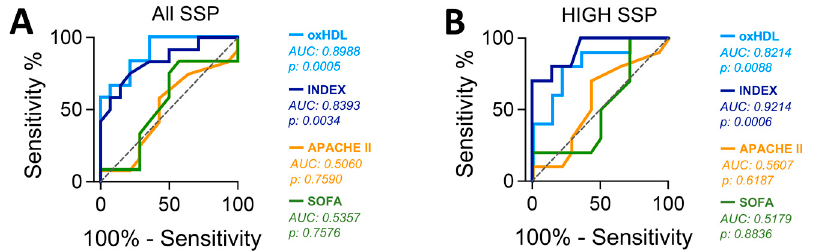
Figure 4. Plasma level of oxHDL and INDEX in SSP. AUROC curve analysis in all SSP ( A ) and non-surviving SSP ( B ) were performed for the plasma level of high-oxHDL (( A ), AUC = 0.8988, p = 0.0005 (95% CI: 0.7835–1.001); ( B ), AUC = 0.8214, p = 0.0885 (95% CI: 0.6480–0.9948)), high-INDEX (( A ), AUC = 0.8393, p = 0.0034 (95% CI: 0.6838–0.9948); ( B ), AUC = 0.9214, p = 0.0006 (95% CI: 0.8155–0.9998)), APACHE II (( A ), AUC = 0.5060, p = 0.7590 (95% CI: 0.2753–0.7366); ( B ), AUC = 0.5607, ( B ), AUC = 0.5179, p = 0.8836 (95% CI: 0.2738–0.7619)) scores. A diagonal discontinuous line